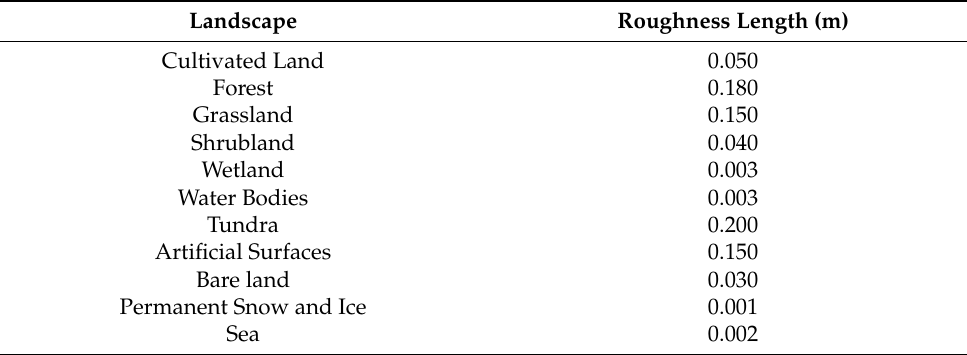
Table 3. Roughness length provided by Globeland30.